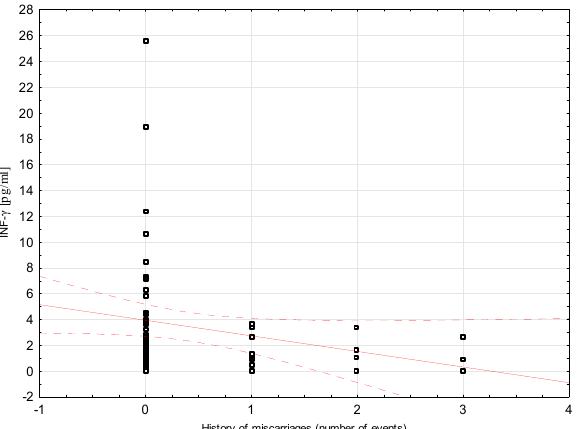
Figure 2. A scatter graph showing the correlation between the number of miscarriages and the INF- γ concentration assessed in the blood serum of patients from the study group.